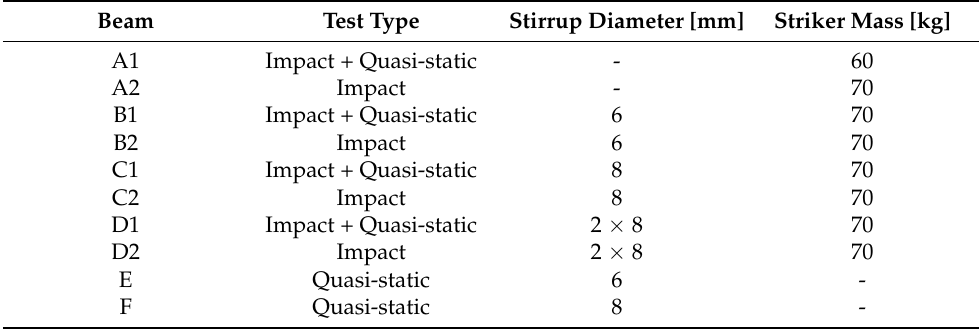
Table 1. Details of the